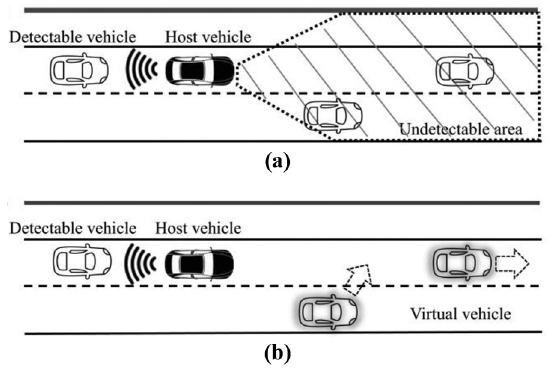
Figure 3 Explanations of virtual vehicle schemes